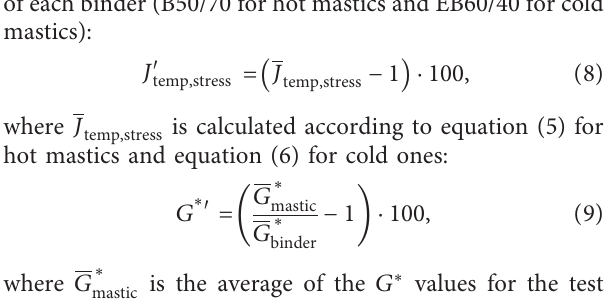
′ and G ∗ ′ temp , stress